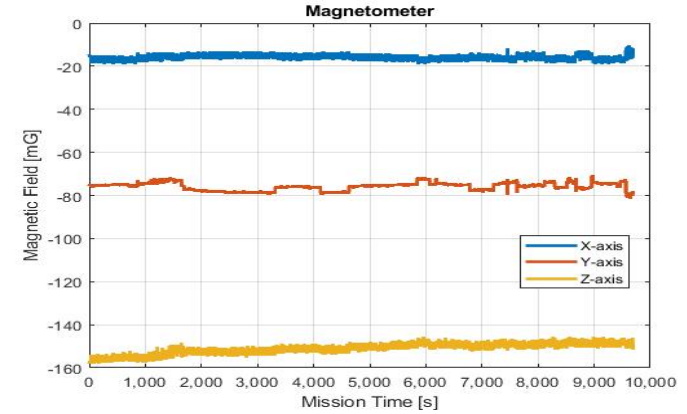
Figure 16. Magnetic Field measured during the environmental test.